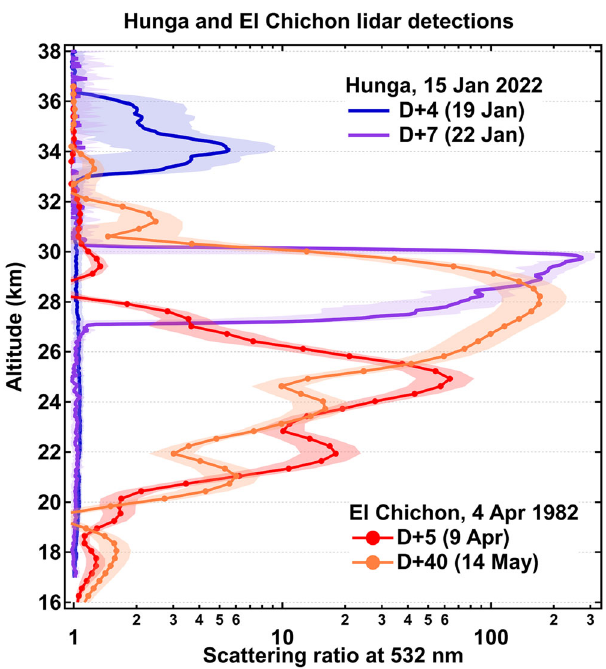
Fig. 3 Comparison of the Hunga and El Chichon plumes observed by lidars at La Reunion and Mauna Loa observatories. The fi gure includes the scattering ratio (SR) pro fi les corresponding to the earliest detections of volcanic plume (blue and red pro fi les) as well as to the most intense aerosol layers in terms of their peak scattering ratio (violet and orange pro fi les). The Mauna Loa lidar measurements at 694 nm were converted to 532 nm using the color exponent of 0.9 (Jager and Deshler, 2022). Note that the El Chichon plume obtains its maximum SR much later than the Hunga